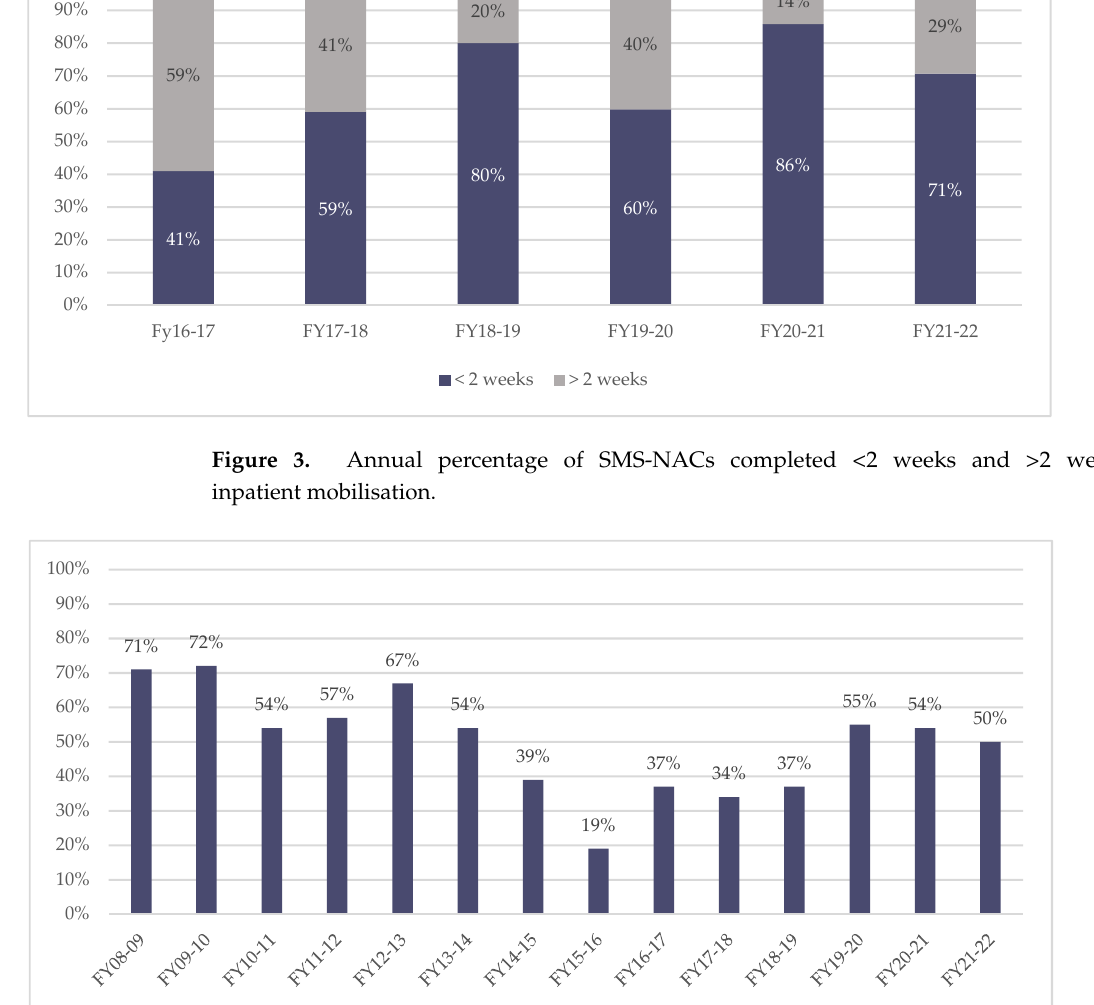
Figure 4. Annual percentage of second SMS-NACs completed of first SMS-NACs.